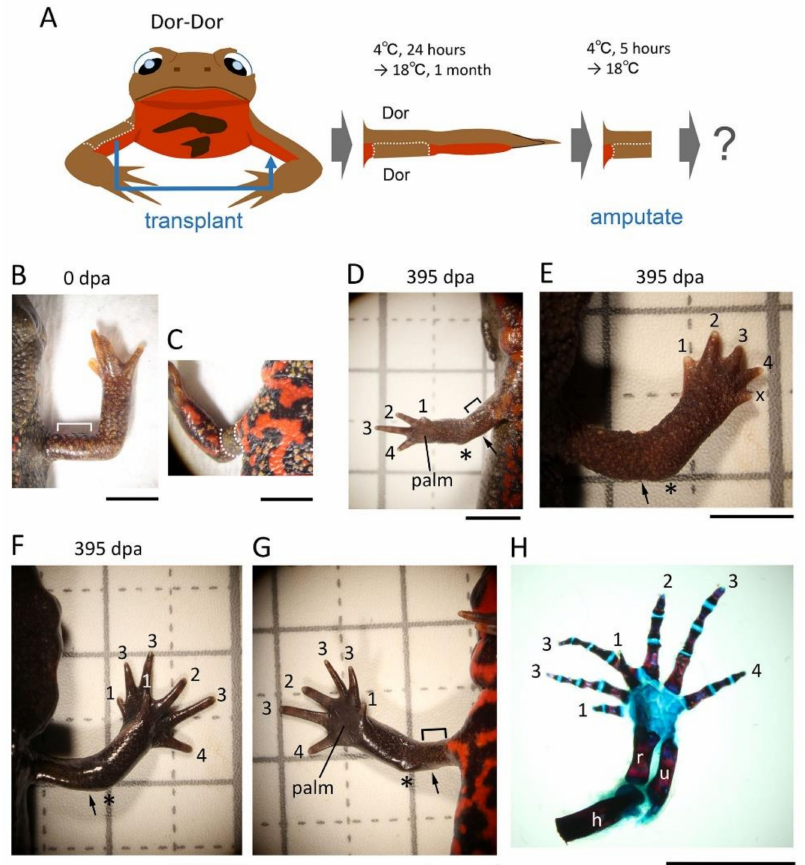
Figure 6. Effects of Dorsal-Dorsal (Dor-Dor) skin grafting on limb regeneration. ( A ) Schematic showing the surgical process. ( B , C ) A limb immediately before amputation. The image in ( C ) is a ventral view of the limb shown in B . Dotted lines indicate the border of the grafted skin. ( D ) Representative showing normal regeneration (ventral view; n = 19). ( E ) A limb with a 5-digit hand (dorsal view; n = 1). ( F – H ) Representative showing a limb with a supernumerary digit hand (n = 5). In this case, the two right hands seemed to partially overlap and fuse together. ( G ) is a ventral view of the limb shown in ( F ). ( H ) shows a dorsal view of the skeleton of the limb shown in ( F ). The number near the digit indicates digit number. X indicates the digit whose number could not be determined. The asterisk indicates the elbow. The arrow indicates the amputation position. dpa: day post amputation; u: ulna; r: radius; h: humerus. Scale bars: 5